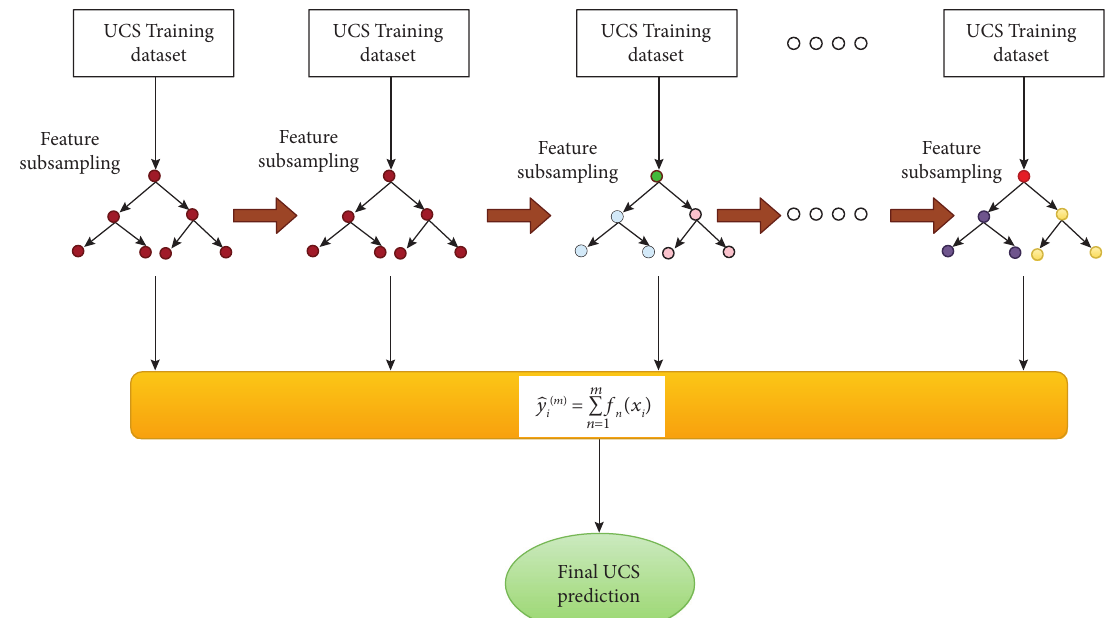
Figure 5: Description of GBR employed in this